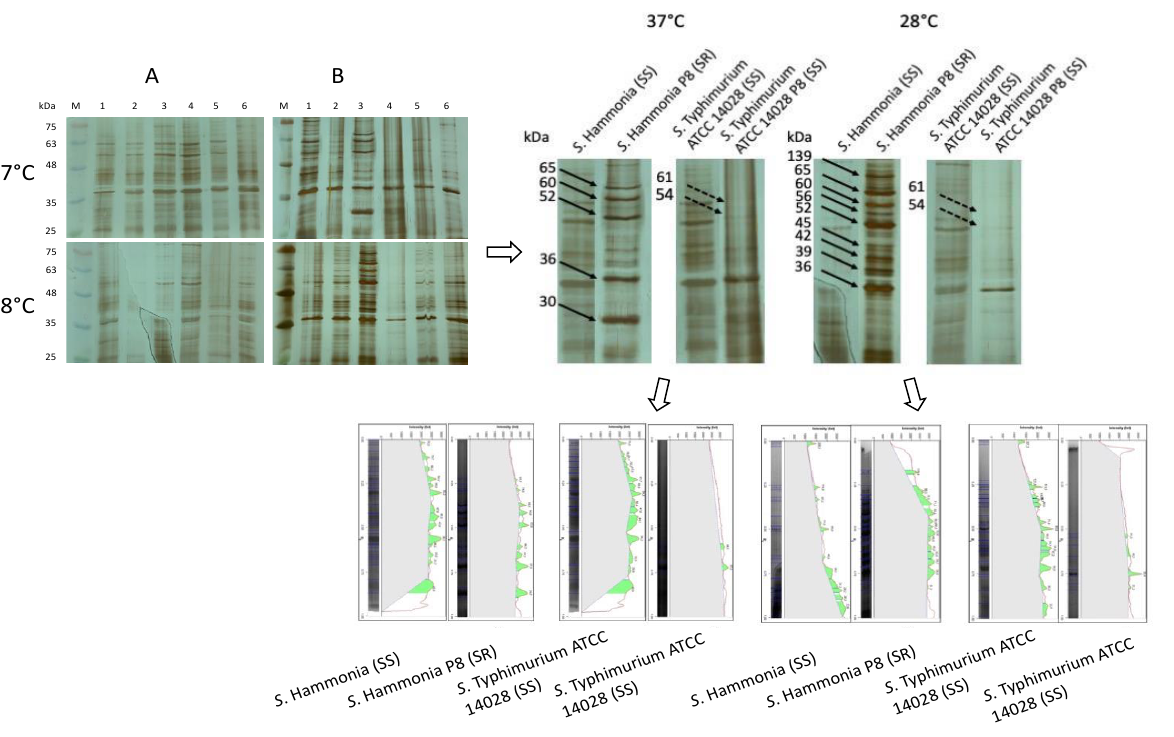
Figure 3. SDS- PAGE analysis of the membrane protein (MP) profiles (12 μg/10 μL per well) of the studied Salmonella enterica isolates. Definitions of abbreviations: M — protein marker (AppliChem, Darmstadt, Germany), Line 1 — S. Isaszeg , Line 2 — S . Erlangen, Line 3 — S. Hammonia, Line 4 — S . Typhimurium ATCC 14028, Line 5 — S. Enteritidis ATCC 13076, Line 6 — S. Senftenberg; ( A ) WT (serum sensitive, SS) Salmonella strains, ( B ) Salmonella strains passaged eight times in 50% SPPP (P8); SR — serum resistant. The bottom half of Figure 3 represents densitograms obtained with Image Lab. V. 4.1 (Bio-Rad, Hercules, CA, USA).